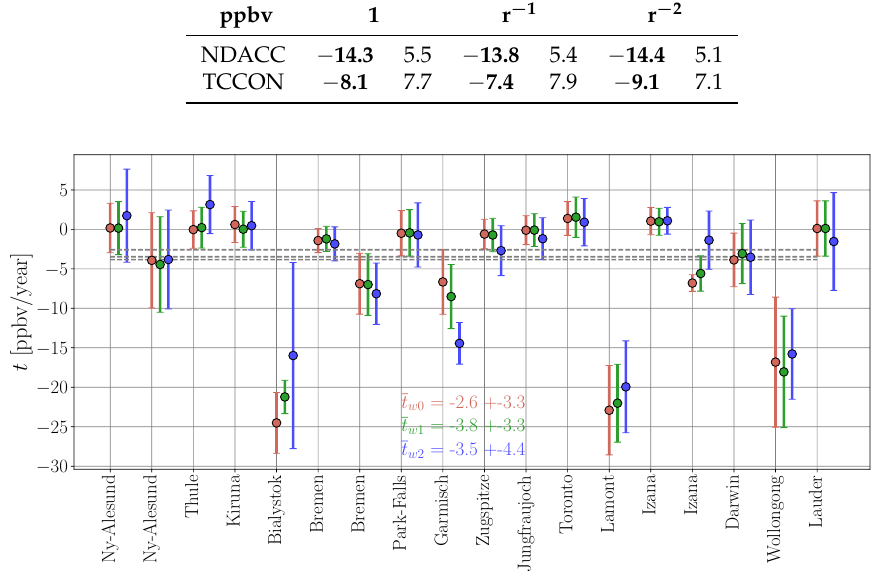
Figure 10. Linear bias trend t of the mean biases b for the classical (unweighted) and weighted approaches. No significant bias trend is identified on the global scale, however, a few sites do show a significant negative bias